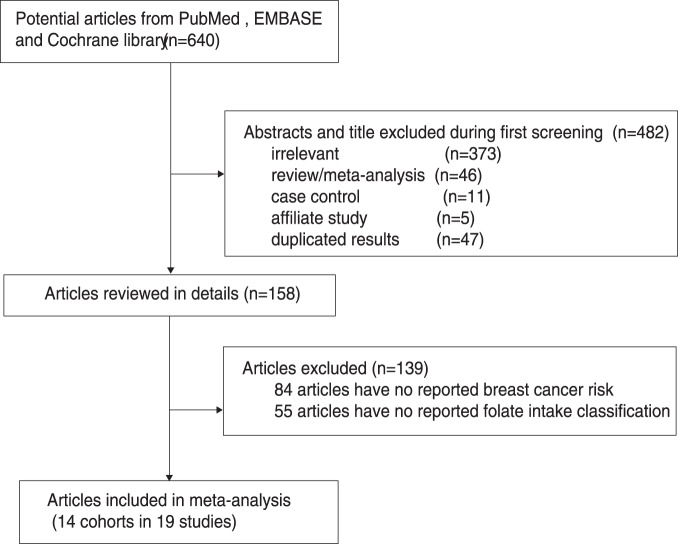
Flow diagram of the literature search and studies selection process.